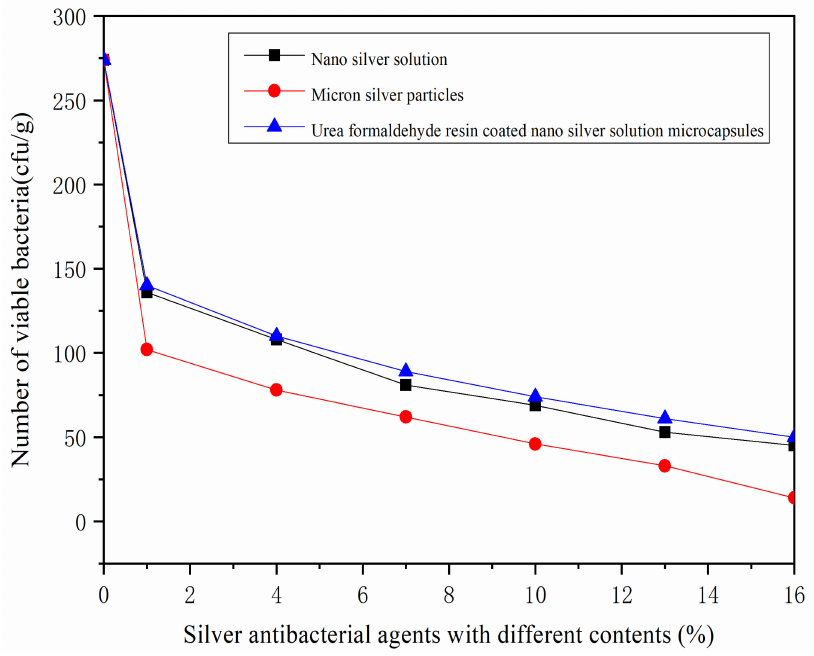
Figure 8. Number of surviving colonies in the coating with micron silver particles, nano-silver solution, and urea formaldehyde resin-coated nano-silver solution microcapsules.